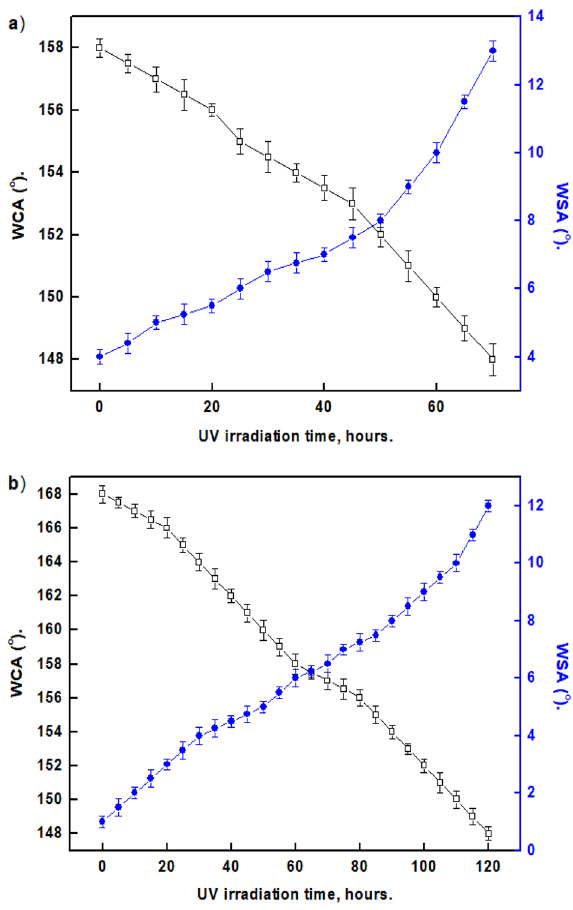
Figure 13. Effect UV-irradiation period on WCA and WSA of the coated steel by ( a ) Ni@G@MA and ( b ) Ni@ Cr-G@MA.